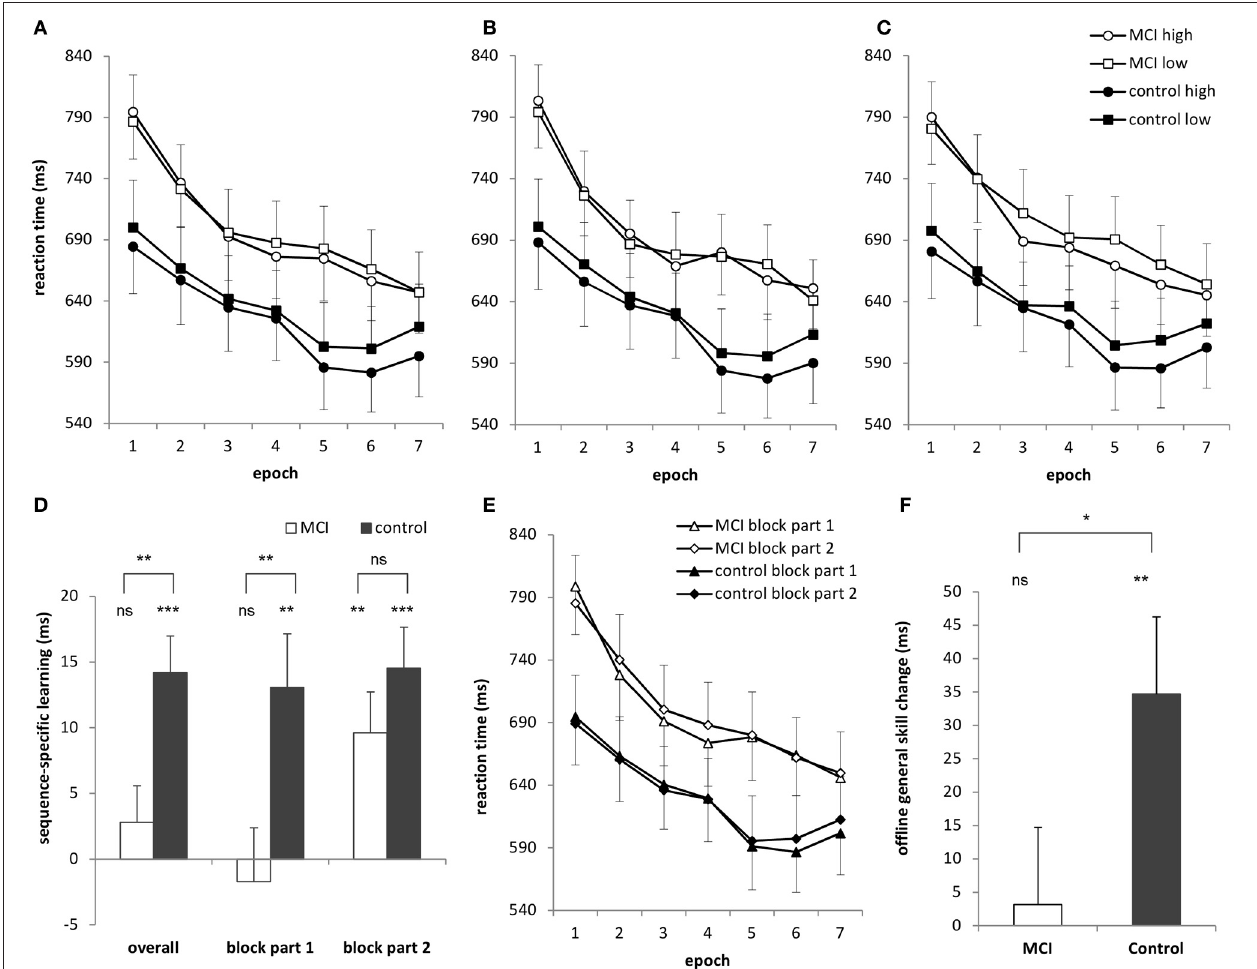
FIGURE 1 | (A) Sequence learning across 7 epochs (35 blocks) for the MCI and control group. Circles represent RTs for high-frequency triplets and squares represent RTs for low-frequency triplets. (B) Learning curves for the first part of each block and (C) the second part of each block. (D) Sequence-specific learning (measured by the RTs for the low- minus high-frequency triplets) for the MCI and control group is plotted for the overall, first block-part and second block-part learning measures. Overall, the MCI group did not show significant sequence-specific learning, which was caused mainly by the learning performance in the first part of the blocks. The learning performance in the second part of the blocks was